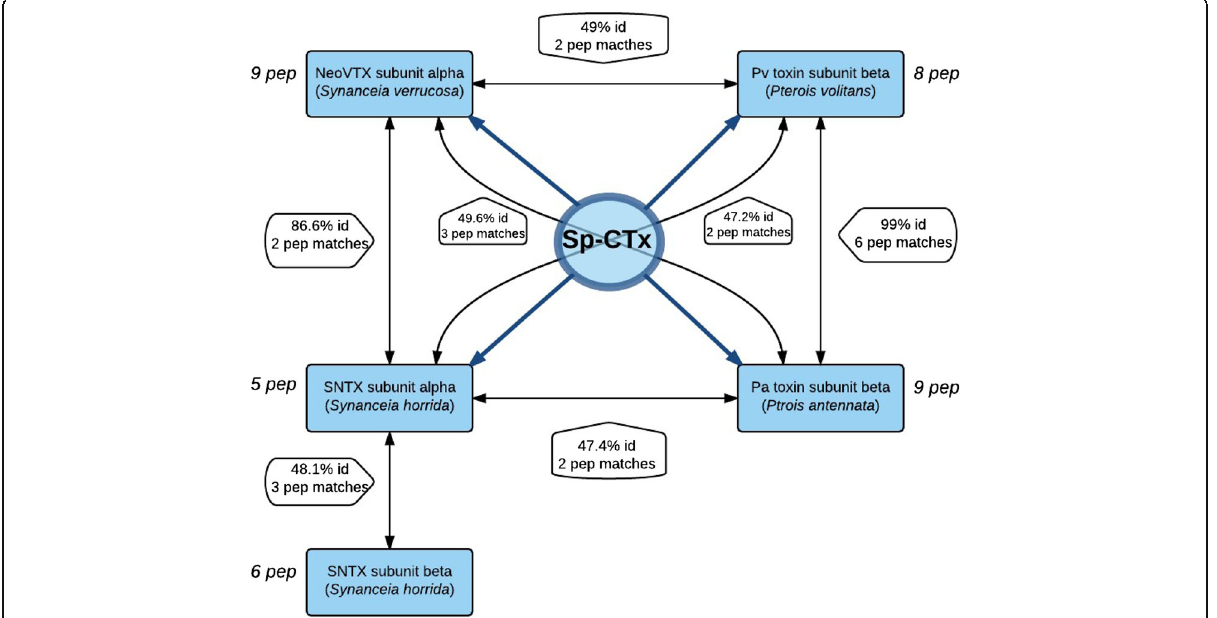
Fig. 4 Identity percentage (coverage id) between fish toxins (blue boxes). The number of Sp-CTx-predicted tryptic peptides (pep “ matches ” ) shared between corresponding subunits is represented along with the respective percentage values. The “ pep ” values depicted beside each blue box stand for the number of Sp-CTx-predicted peptide fragments that are shared with each appointed